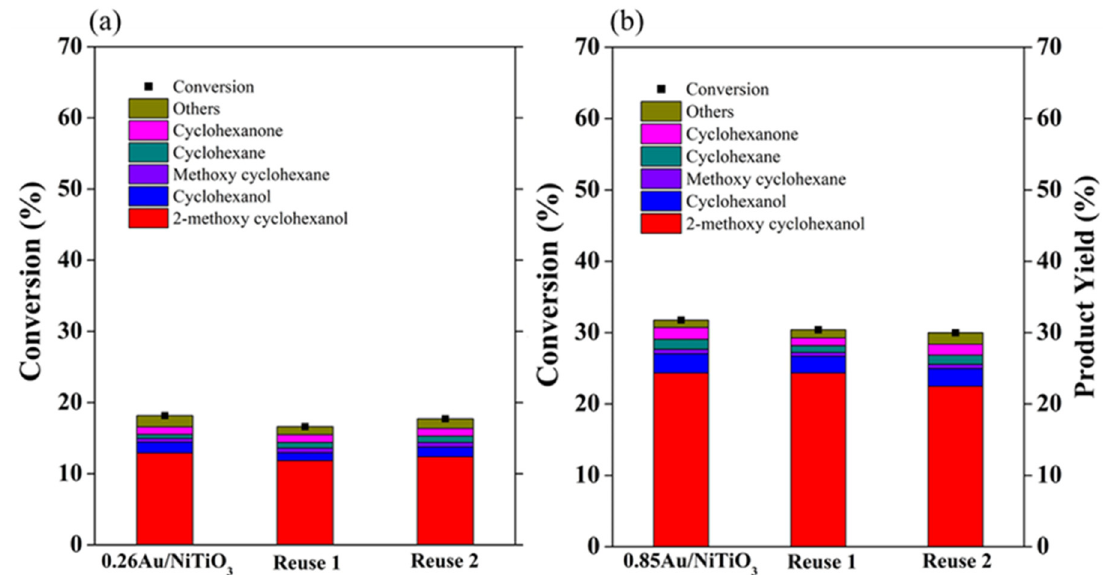
Figure 8. Performance of 0.26 Au/NiTiO 3 ( a ) and 0.85 Au/NiTiO 3 ( b ) in three consecutive tests with reuse of the catalysts. Reaction conditions: catalyst 0.2 g, guaiacol 1.30 g, decane 25 mL, P (H 2 ) = 3 MPa, 300 °C, 700 rpm.